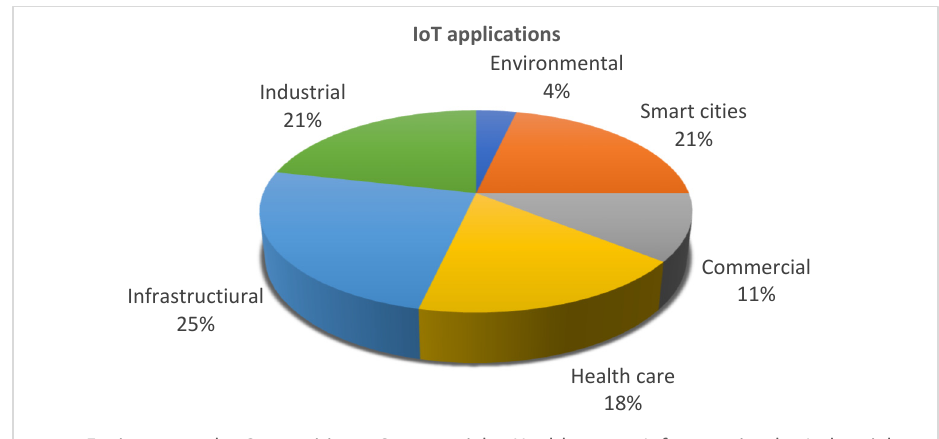
Figure 5. Amount of IoT applications in different spaces.